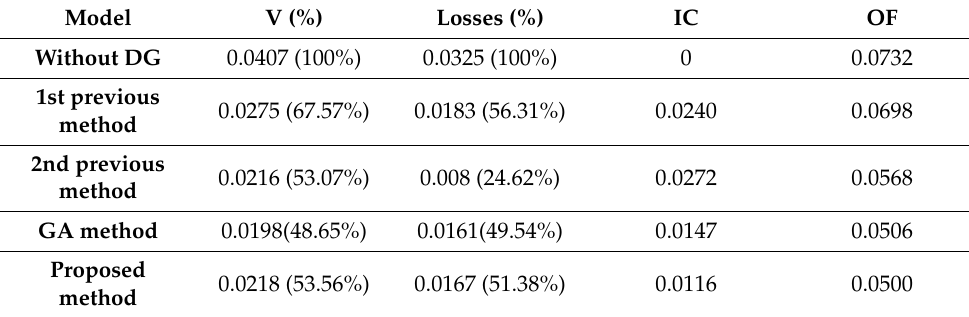
Table 5. Value of the objective function (the IEEE 14-bus test